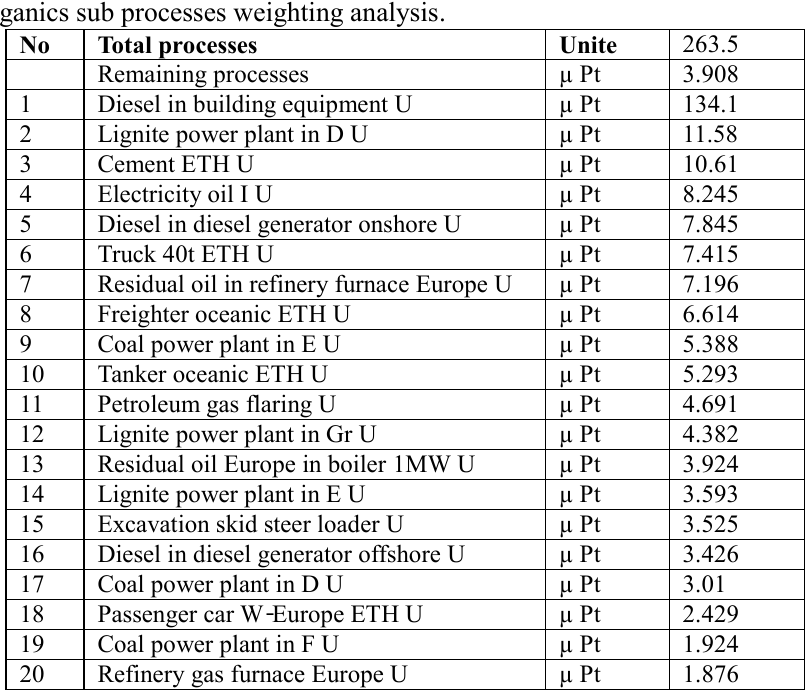
Table 4 Respiratory inorganics sub processes weighting